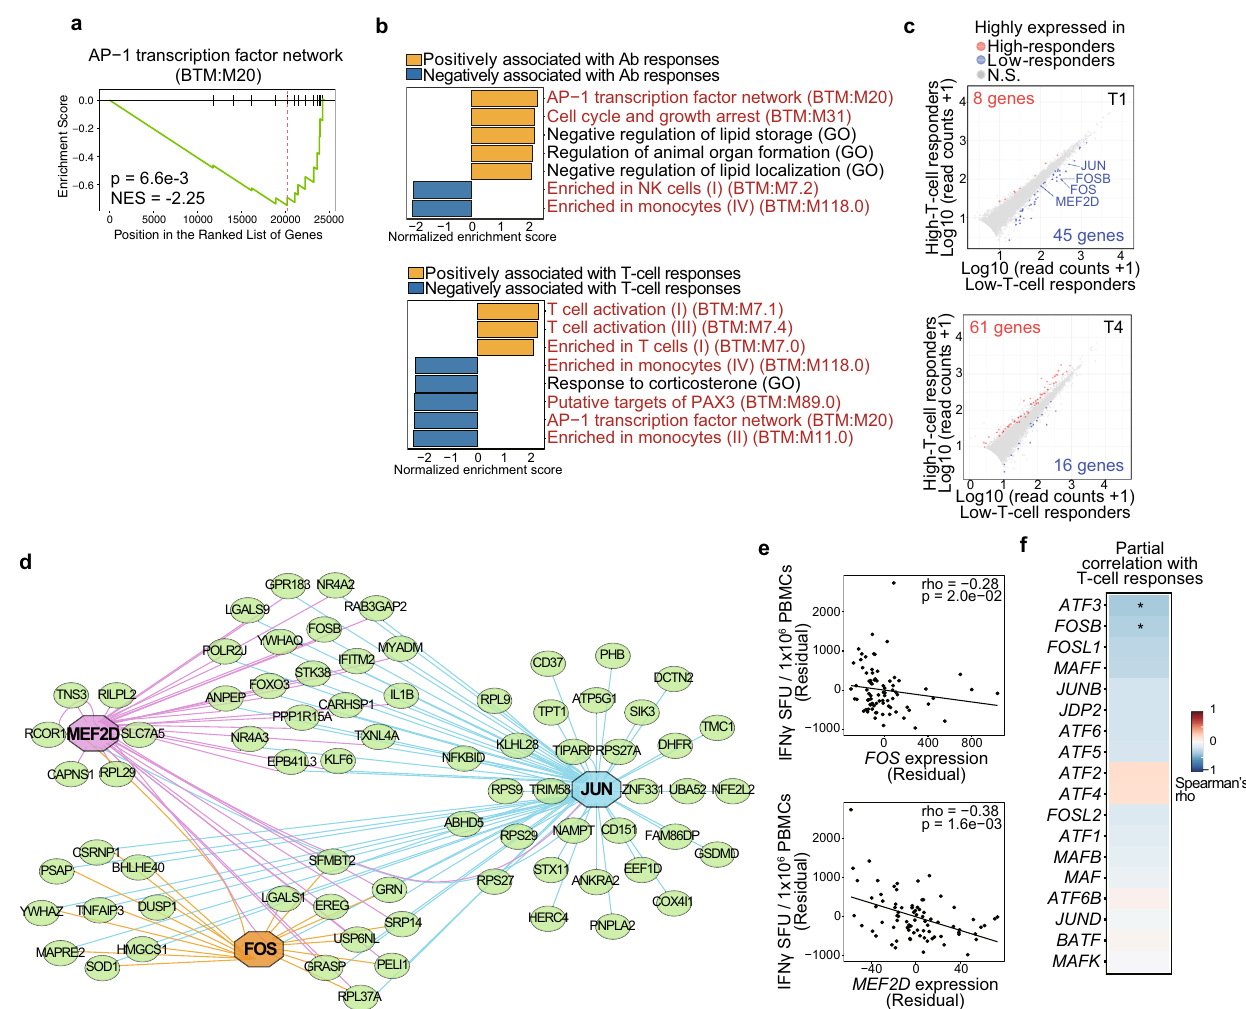
Fig. 3 Transcripts associated with BNT162b2-induced adaptive immunity. Transcriptomes of PBMCs isolated at time points T1 and T4 were analyzed by bulk RNA-seq. a AP-1 transcription factor network was identi fi ed in GSEA on a ranked gene list based on the Spearman ’ s correlation coef fi cient between RNA expression and vaccine-induced T-cell responses in the validation cohort ( n = 43). NES normalized enrichment score. b GSEA on a ranked gene list based on the Spearman ’ s correlation coef fi cient between RNA expression and vaccine-induced T-cell or antibody responses in the entire cohort ( n = 86). Immune-related pathways are shown in red. c Scatterplots showing DEGs between high- ( n = 18 at T1, n = 19 at T4) and low- ( n = 19 at T1, n = 18 at T4) T-cell responders in the entire cohort. DEGs: differentially expressed genes (log2 FC > 0.5, adjusted P < 0.05). Blue and red dots indicate genes that were highly expressed in the sample groups shown on the X axis and Y axis, respectively. N.S. not signi fi cant. d Gene regulatory network analysis of DEGs between high- and low-T-cell responders in the entire cohort. e Scatterplots showing correlations between vaccine-induced T-cell responses and expression of FOS and MEF2D . SFU, spot-forming units. Spearman ’ s rho coef fi cient and P values are indicated in the plots. f Heat map showing correlations between vaccine-induced T-cell responses and expression of AP-1 genes ( n = 86). a , b , e, f Partial correlation analyses with adjustments for age and sex were performed with Spearman ’ s correlation tests with Benjamini – Hochberg FDR